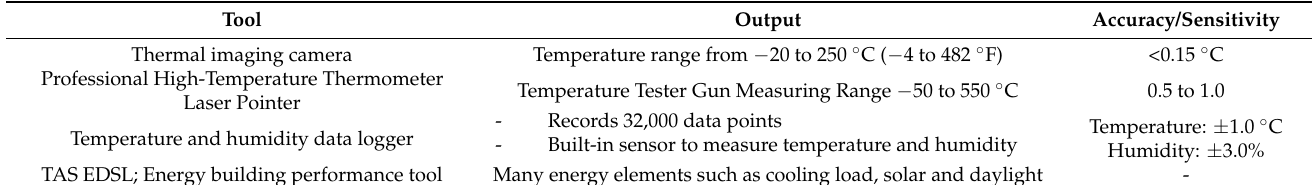
Table 1. Tools and equipment used in the research study.